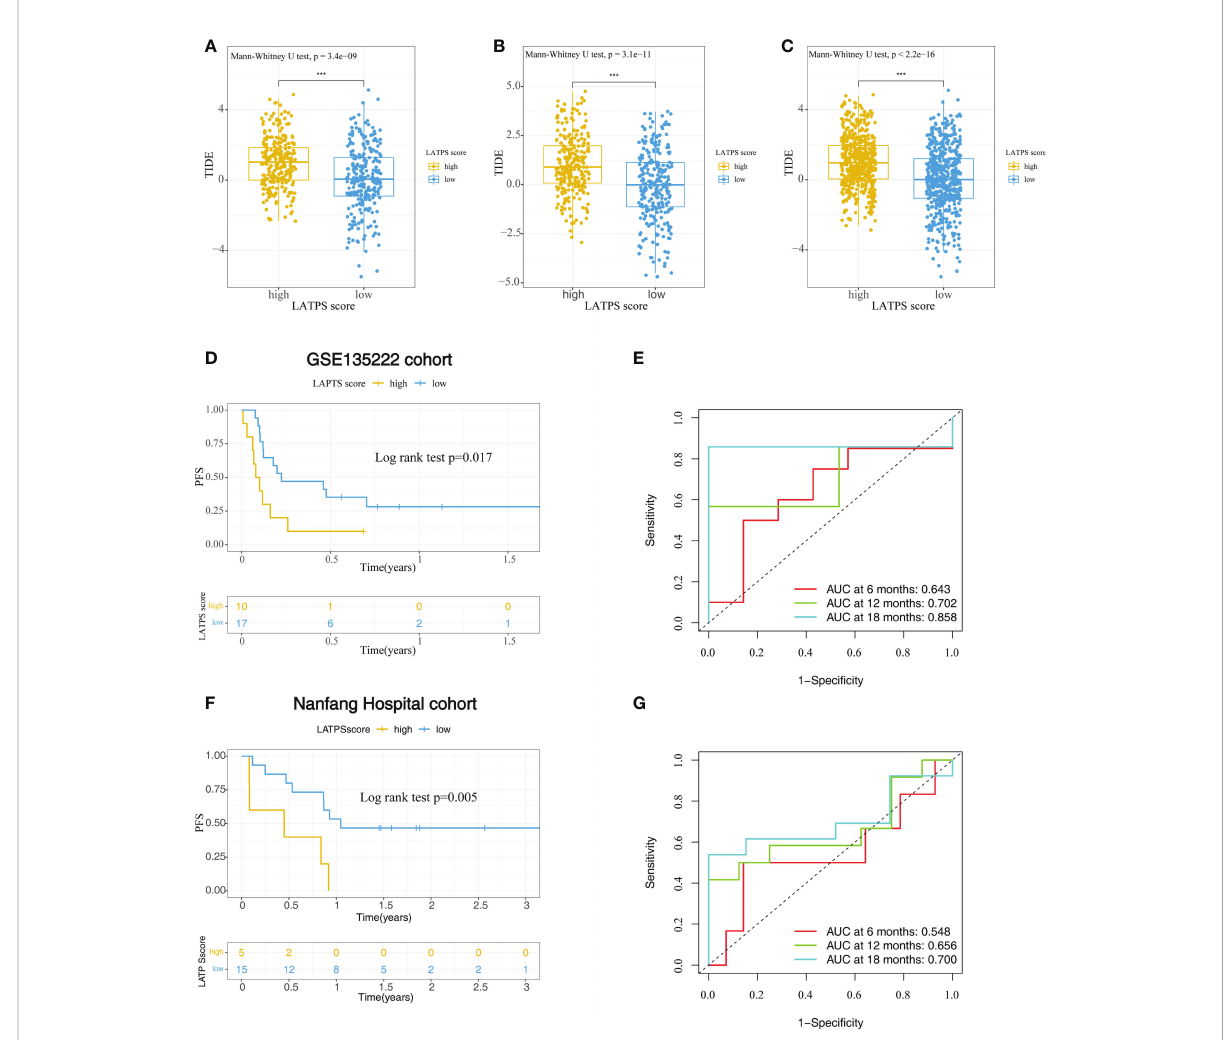
FIGURE 5 The role of the LATPS in the prediction of immunotherapeutic bene fi ts. The relative distribution of TIDE was compared between the LATPS-high and LATPS-low subgroups in the (A) training, (B) test, and (C) total cohorts. (D, E) Kaplan – Meier curve and ROC curve analyses of the LATPS for predicting immunotherapy bene fi ts in GSE135222 cohort. (F, G) Kaplan – Meier curve and ROC curve analyses of the LATPS for predicting immunotherapy bene fi ts in Nanfang Hospital cohort. LATPS, LUAD tumor microenvironment prognostic signature; ROC, receiver operating